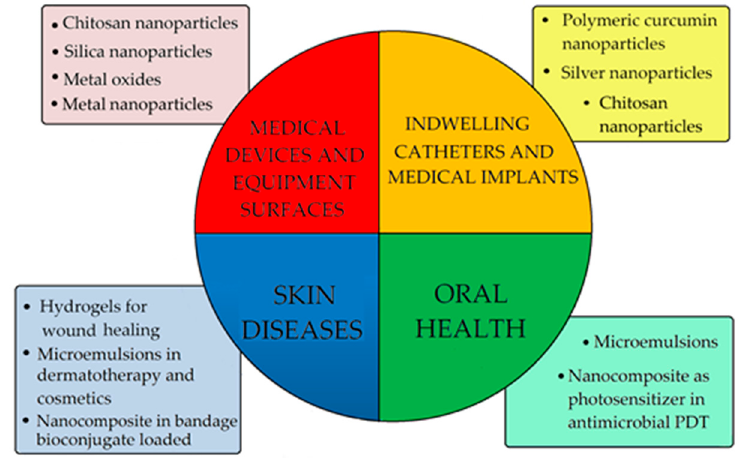
Figure 8. The main fields of use of curcumin in the medical field and its types of formulations in applications.